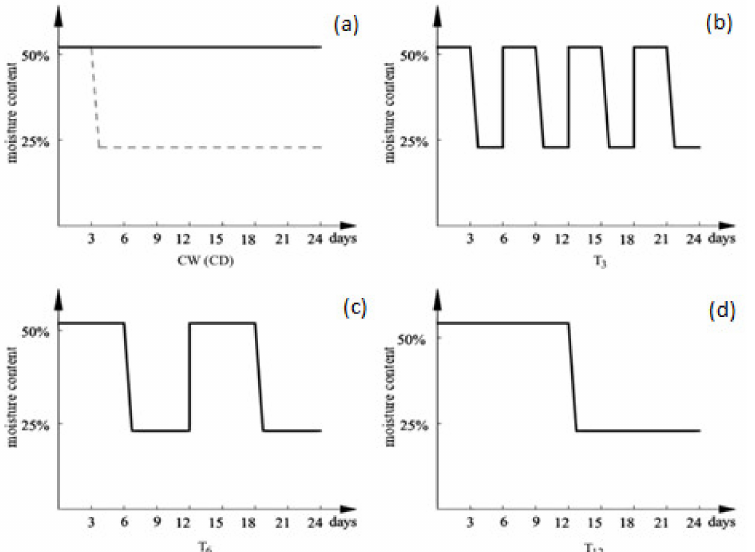
Figure 1. Moisture content design of different drying-rewetting treatments: ( a ) Continuously wet (solid line), continuously dry (dotted line); ( b ) Drying-rewetting alternation at an interval of 3 days; ( c ) 6 days and ( d ) 12